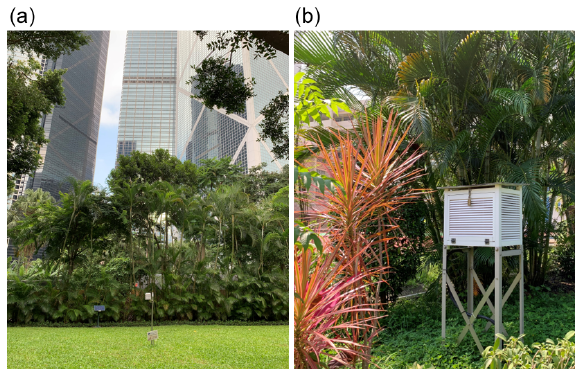
Figure 3. Environment of the HKP (a) and TW (b) meteorological